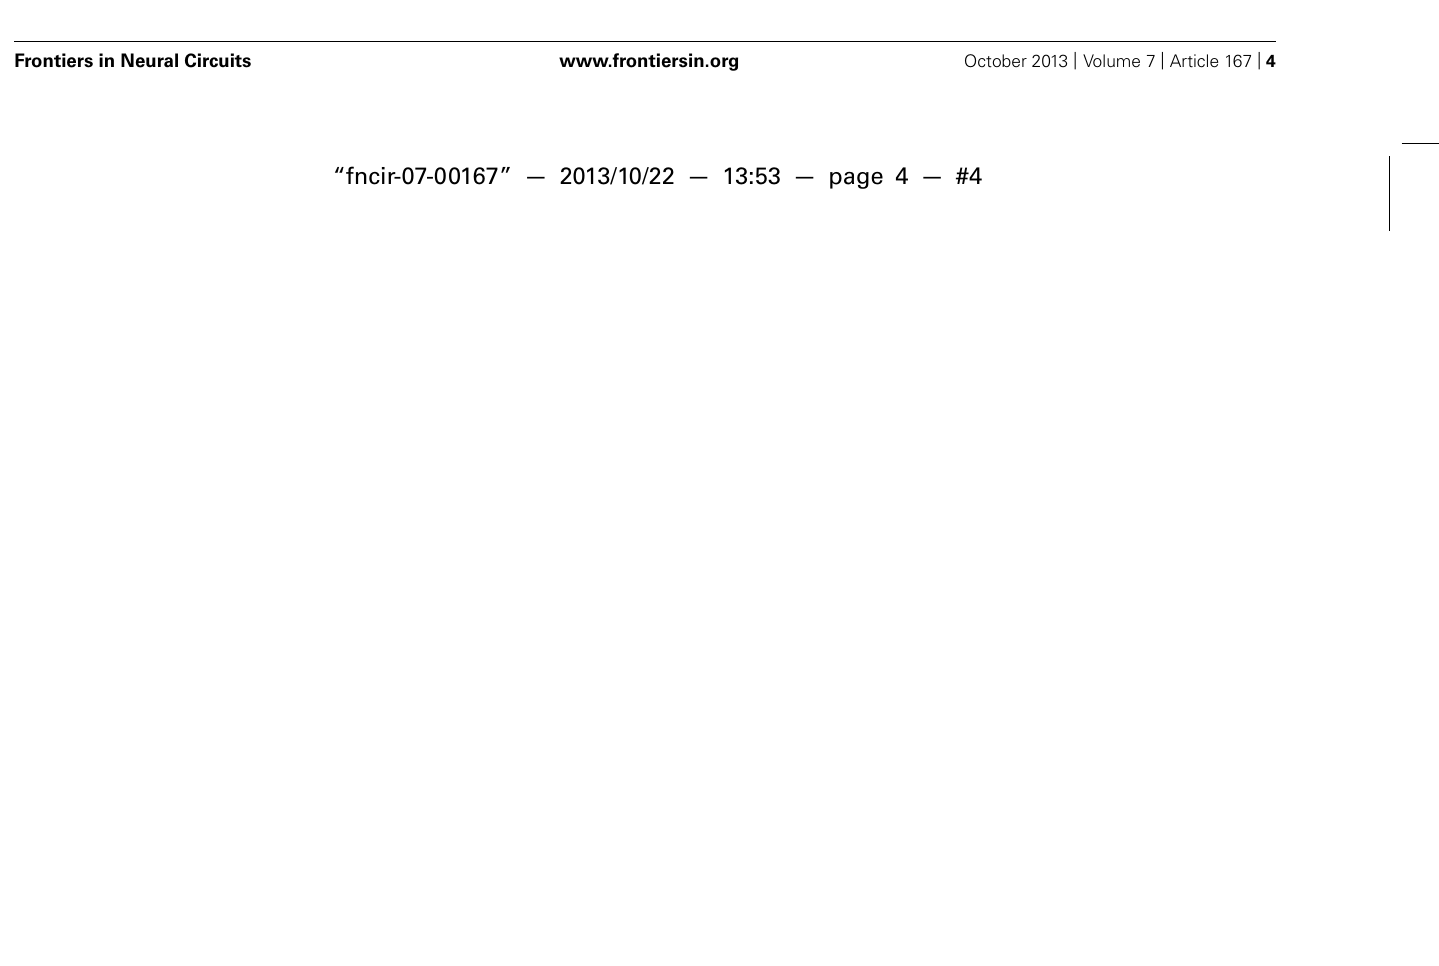
(D) Raster plot of an example burst. The threshold inter-spike interval (ISI), τ , is marked in (D) for comparison. (E,F) Normalized average IBFR of one experiment with fade-in stimulation before and after stimulus (normalized to the peak of average IBFR before stimulus). The red line shows the average IBFR by aligning the bursts by the onset of the detected burst and blue line shows the average IBFR by aligning bursts by their first